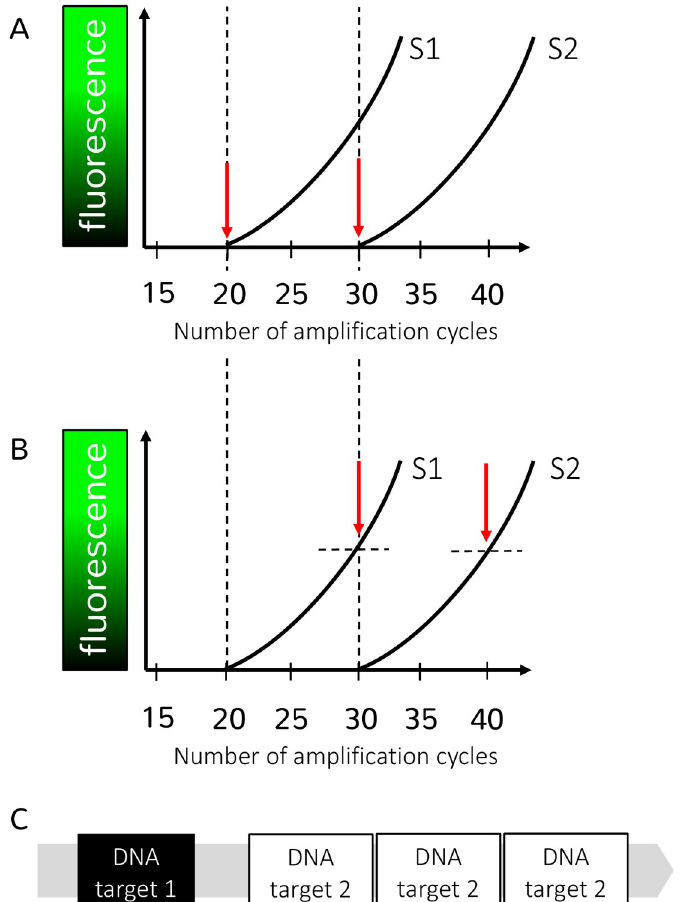
Fig 1. Challenges in relative and absolute quantification of DNA based on Cq units. Panels A and B describe the principles of and challenges in relative quantification of DNA, based on Cq units. The x-axis of these panels shows the number of amplification cycles, and the y-axis shows the level of fluorescence detected at each amplification cycle. The sooner a signal is observed, the higher the initial DNA concentration. To illustrate the effect of 2 qPCR platform- specific approaches to determine the Cq value, the same 2 amplification curves of 2 samples (S1 and S2) are depicted in panels A and B. In panel A, the Cq values are defined as the point where the fluorescence signal becomes detectable from the background (y = 0), and the amplification curves have Cq values of 20 and 30 for sample S1 and S2, respectively. This way of determining Cq values is, for example, used by software of the LightCycler480 qPCR platform (Roche). In contrast, in panel B, Cq values are defined as the point where the amplification curve crosses a threshold (dashed horizontal lines), and the same samples as in panel A have a Cq value of 30 (S1) and 40 (S2). This way of determining Cq values is used, for example, in the software of the StepOnePlus qPCR platform (Applied Biosystems). The principle of relative quantification is also shown in panels A and B. In both panels, the difference between the Cq values of the 2 samples is 10 (Cq 30 − Cq 20 in panel A and Cq 40 − Cq 30 in panel B). Therefore, in both panels A and B, S1 contains approximately 1,024 (2 difference in Cq = 2 10 = 1,024) times more DNA than S2. Although in both panels this relative quantification of both samples is the same, the Cq values of the same samples differ substantially across the different platform-specific approaches. Furthermore, the absolute quantity of DNA is unknown, rather, it describes the quantity in samples relatively to each other (relative quantification). Panel C describes the challenges in absolute quantification of DNA based on Cq units. The gray bar represents a simplified genome of an STH species (e.g., Trichuris trichiura ). DNA target 1 is a single-copy target, meaning that it is present only once in the whole genome. DNA target 2 is a multi-copy target, meaning that this target is present multiple times in the genome. As an example, laboratory A uses a single-copy gene as a DNA target to detect and quantify T . trichiura and reports a result of 100 genes/mL DNA extract. Laboratory B uses a multi-copy gene as a DNA target and reports a result of 300 genes/mL DNA extract. Because of the unknown quantitative relationship between these 2 genes in the T . trichiura genome, it is also unknown if both laboratories report the same T . trichiura DNA concentration. If both laboratories would express their qPCR results in GE/mL of DNA extract, both would theoretically find the same concentration of 100 GE/mL. Cq, cycle of quantification; GE/mL, genome equivalents per mL; qPCR, quantitative PCR; STH, soil-transmitted